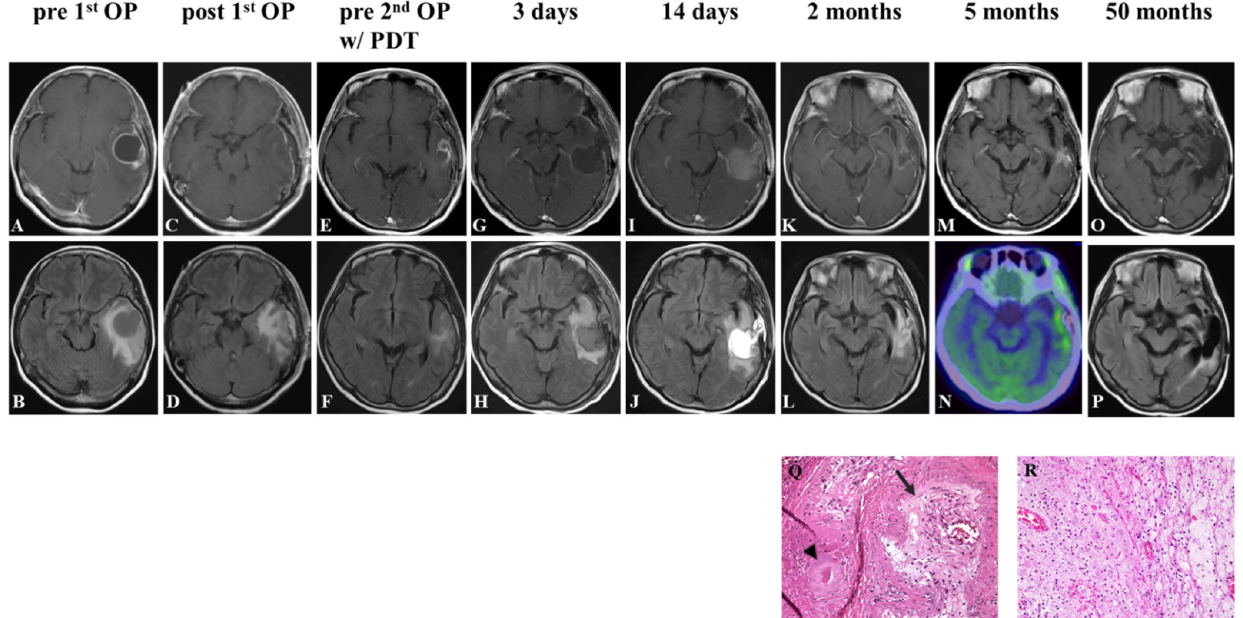
Figure 6. Representative Case 2. Contrast-enhanced T1-weighted and FLAIR MR image before ( A , B ) and after ( C , D ) the first operation. Contrast-enhanced T1-weighted and FLAIR findings before the second operation with PDT ( E , F ); 3 days ( G , H ); 2 weeks ( I , J ); 2 months ( K , L ); 5 months ( M ), and 50 months ( O , P ) after the second surgery. PET study at 5 months postoperatively ( N ). The pathological results of the suspected recurrent lesion at 5 months postoperatively showed venous infarction ( Q arrowhead) and loss of internal elastic membrane ( Q arrow), but no obvious tumor cells ( R ).